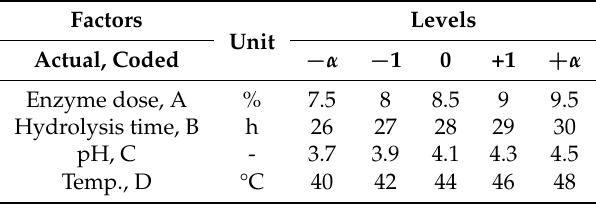
Table 2. Coded variable levels of independent variables used in the CCD *.